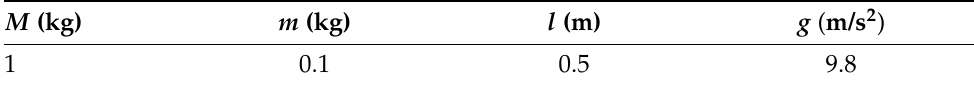
Table 1. Parameters of the X-Z inverted